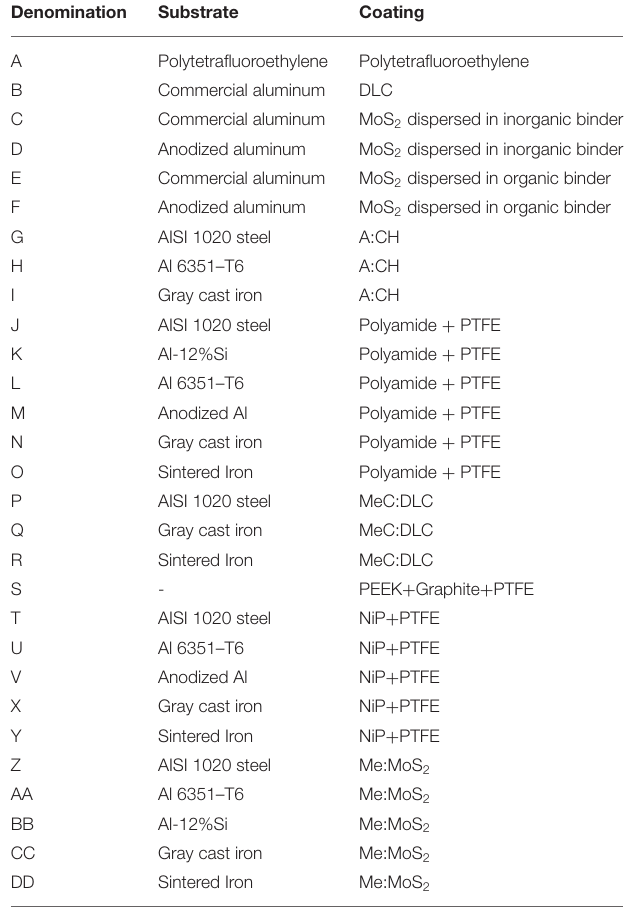
TABLE 2 | Commercially available solid lubricants based